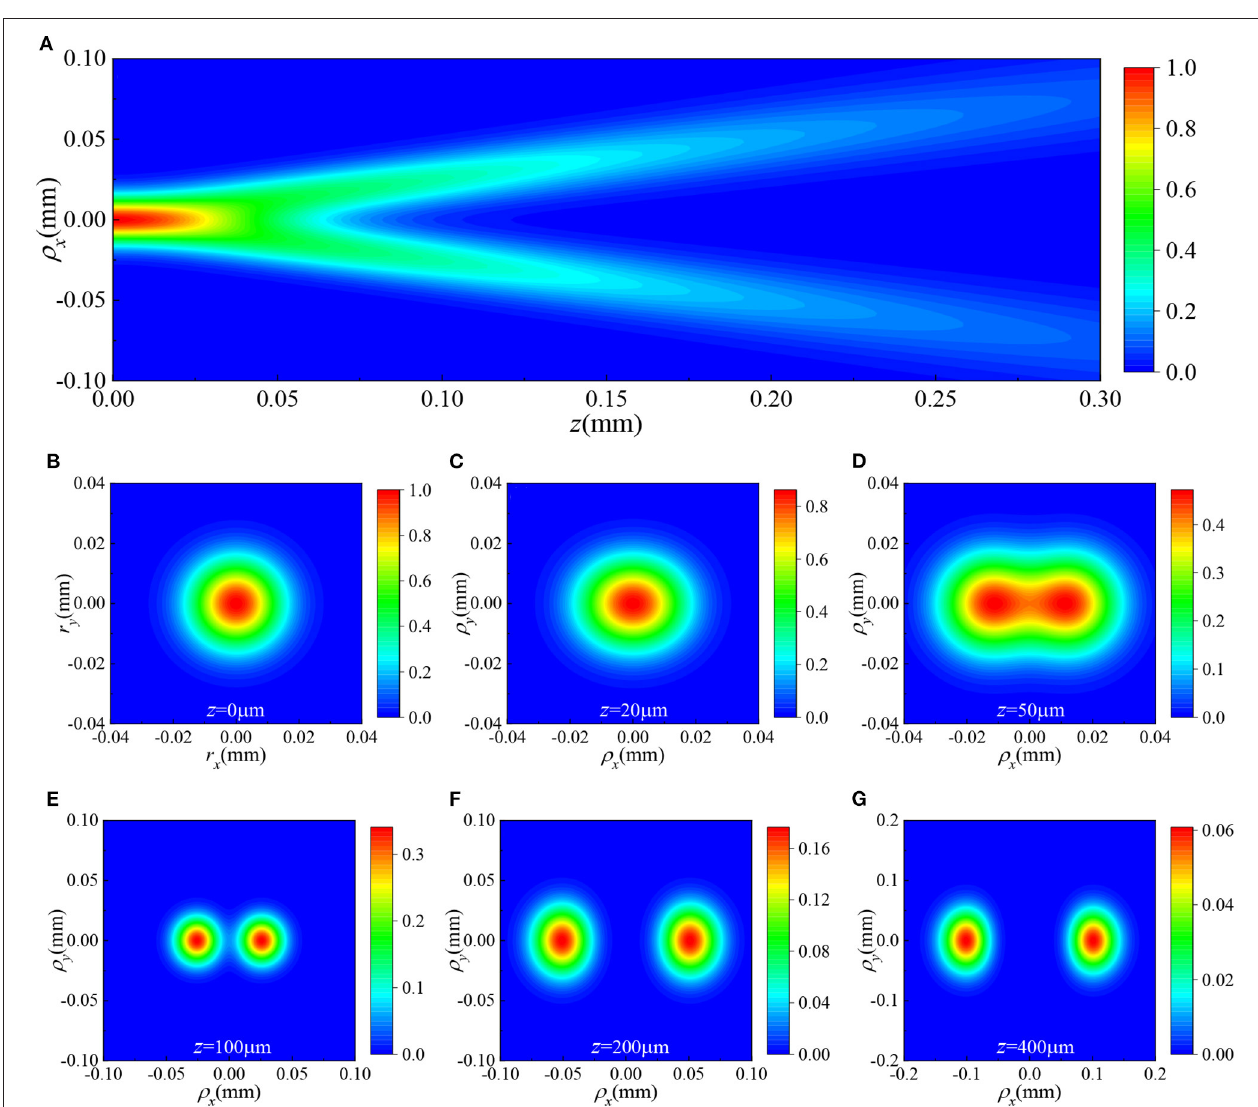
z plane with, ρ y 0, and (B–G) in − =